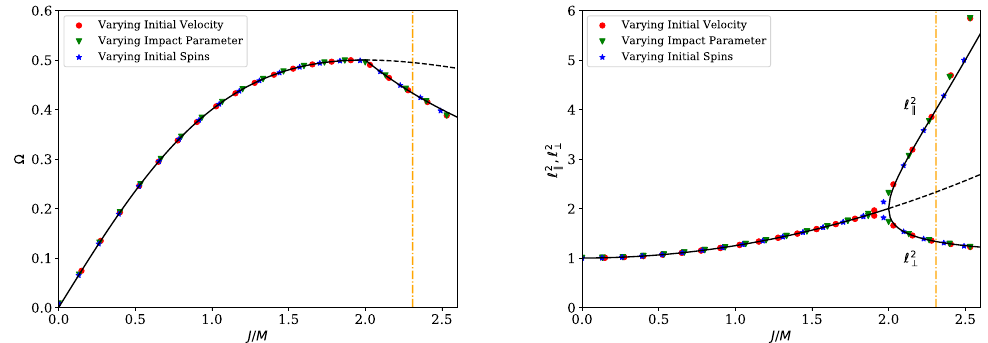
Figure 6 . Final states of collisions for varying impact parameter, initial velocities and spins. The dashed and continuous lines correspond to stationary MP black holes and black bars. The left plot is superimposed on the phase diagram of figure 3. The right plot shows the (squared) longitudinal and transverse axial lengths (cid:31) 2 and (cid:31) 2 described in (2.25) of the final states, and provides more ⊥ (cid:31) and (cid:31) 2 are obtained detailed evidence that the collision forms a rotating black bar. The values of (cid:31) 2 ⊥ (cid:31) by linear regression of log m with respect to r 2 along the longitudinal and transverse directions, respectively. We see that the initial value of J/M (conserved along the evolution) predicts the end state. The vertical dash-dotted orange line shows the onset of the fundamental symmetric mode of the black bar. We observe certain configurations lying beyond this line, but these are not stable: their appearance is an artifact of running the simulation for a finite amount of